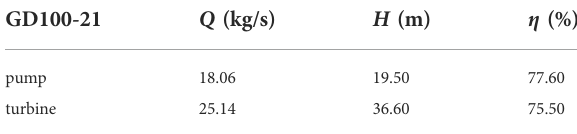
TABLE 10 GD100-21 BEP Point performance characteristic